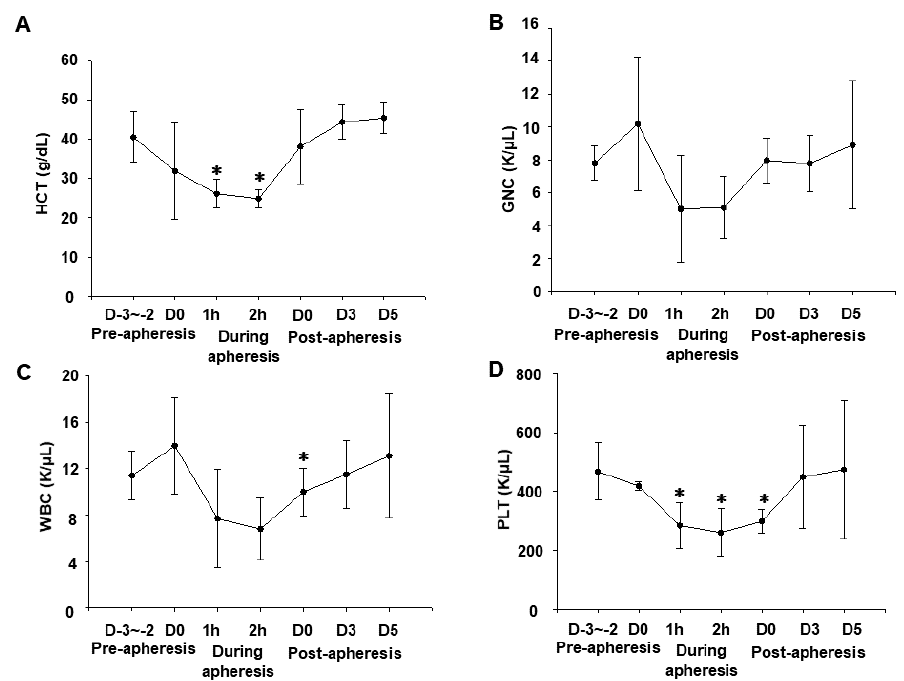
Figure 2. The transition of the values of hematocrit (HCT), granulocytes (GNCs), white blood cells (WBCs), and platelets (PLTs) in dogs. Blood samples were taken from the cephalic vein in pre-apheresis (day (D)-3~2), during apheresis (1, 2 h), and post-apheresis time (D0, 3, 5). Values of HCT ( A ), GNC ( B ), WBC ( C ), and PLT ( D ) were analyzed. Data were shown as mean ± S.E.M ( n = 3). p < 0.05 vs. D-3~-2 pre-apheresis.